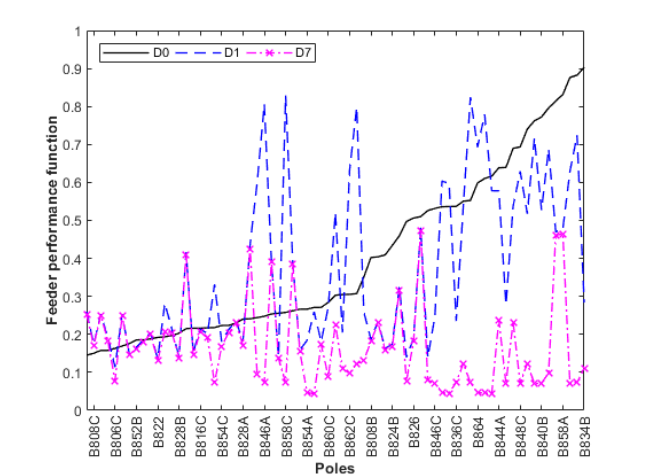
Figure 24. D function evaluation for Case 3 with m = 0.25 and n = 0.75, including the base case (D0); lightning arresters at only the transformer’s pole (D1); and lightning arresters at the transformer’s pole and at the six most critical poles